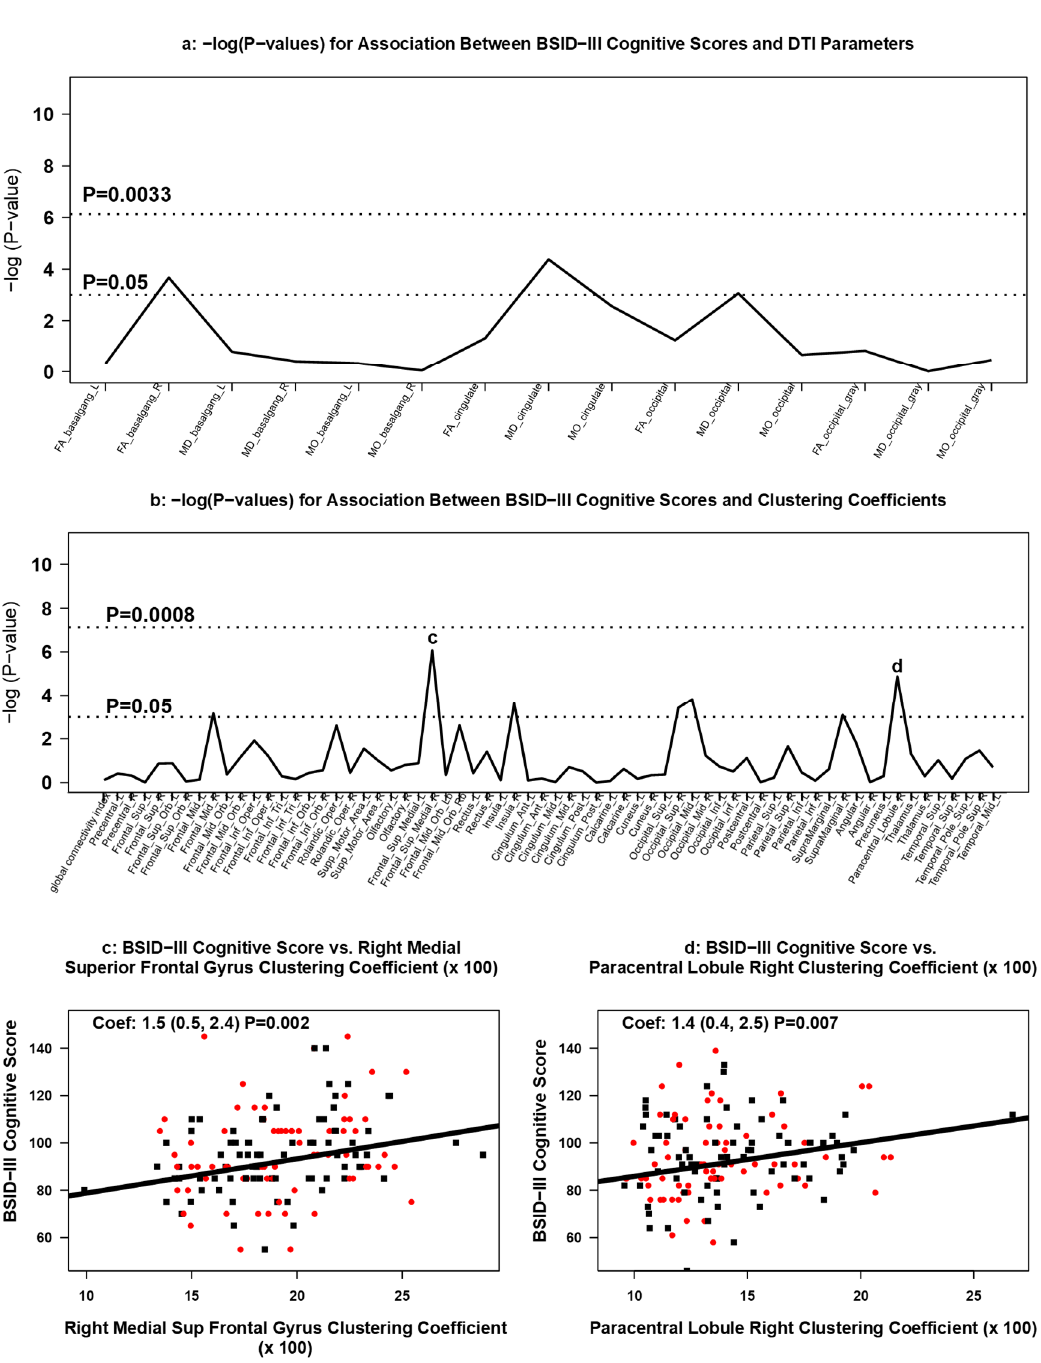
Figure 7. Association between DTI measures and BSID-III cognitive scores. Manhattan plots of [GEE-based Wald test] -log ( p -values) for differences in ( a ) regional DTI diffusion values and ( b ) clustering coefficients by BSID-III cognitive scores. Panels ( c , d ) display scatterplots of BSID-III cognitive scores and statistically significant [GEE-based] associations in clustering coefficients. Red dots represent infants treated with Epo; black squares represent infants treated with placebo.